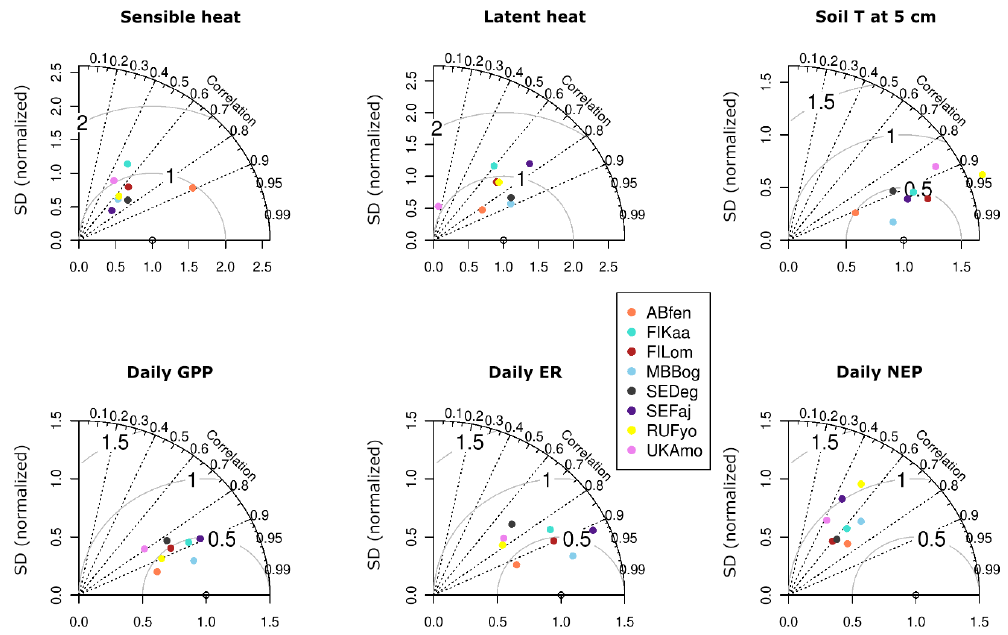
Figure 17. Taylor diagrams of model performance on average sensible heat flux (QH), latent heat flux (QE), soil temperature at 5cm depth, and daily average GPP, ER, and NEP (gCm − 2 d − 1 ) in bogs and